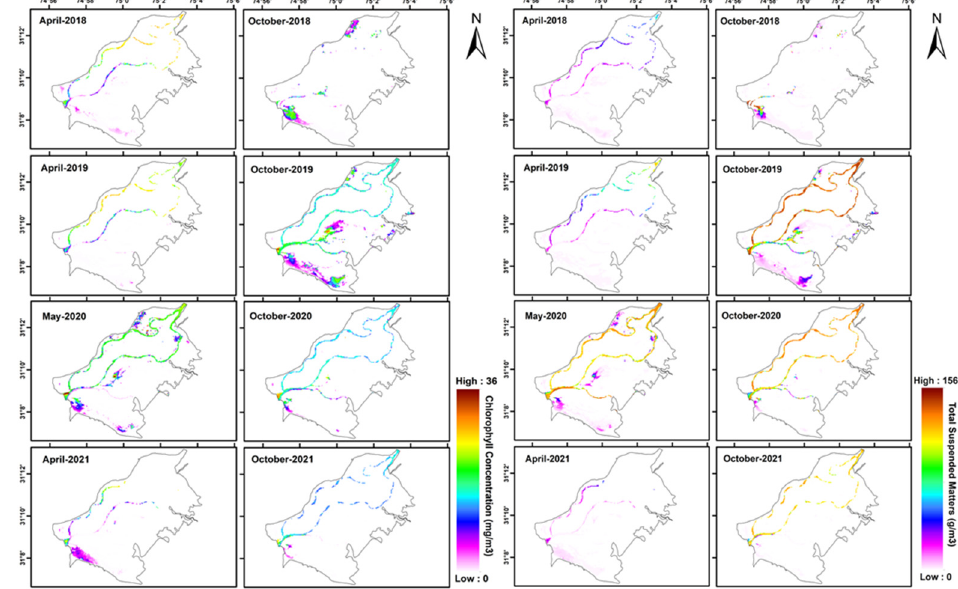
Figure 4. Spatial and temporal variations of chlorophyll concentration ( left side) and total suspended matter ( right side) over Harike during Pre- and Post-monsoon season from 2018 to 2021.